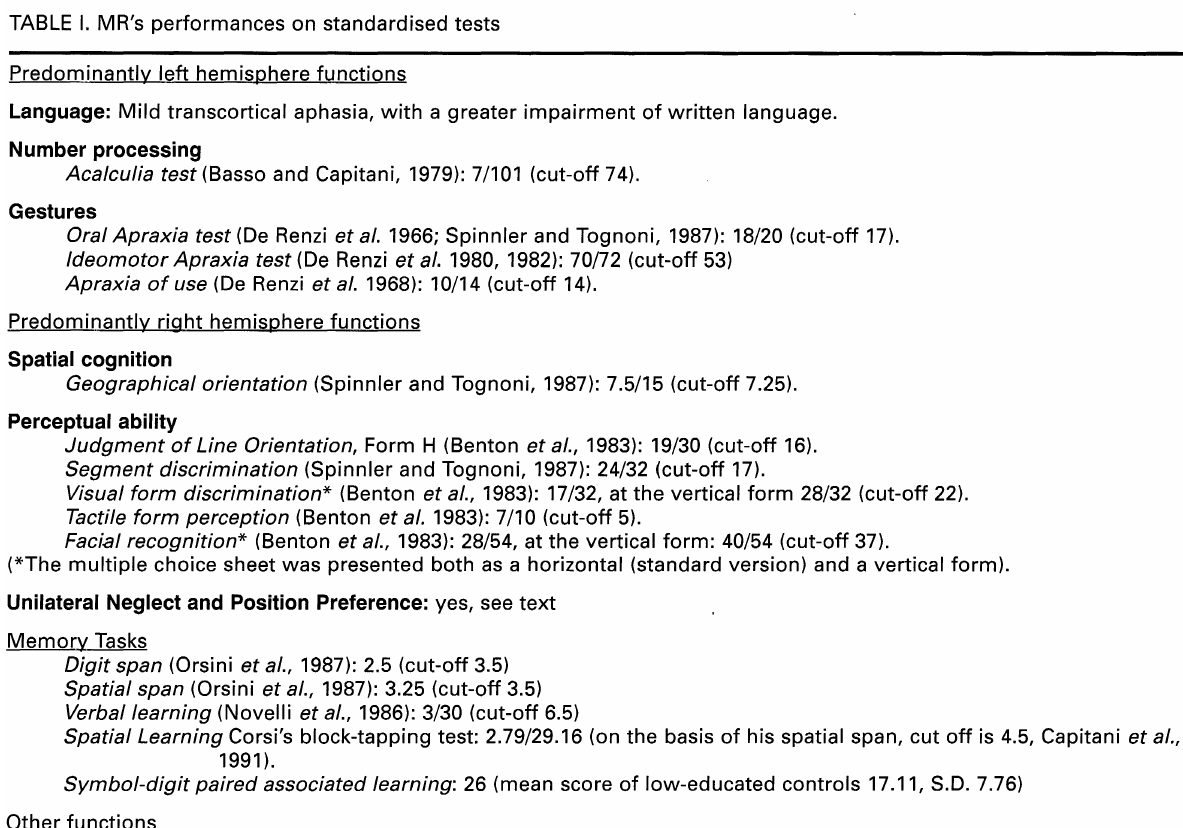
TABLE I. MR's performances on standardised tests Predominantly left hemisphere